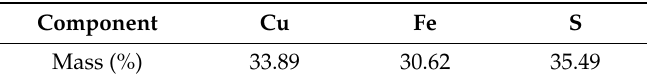
Table 1. Chemical analysis of